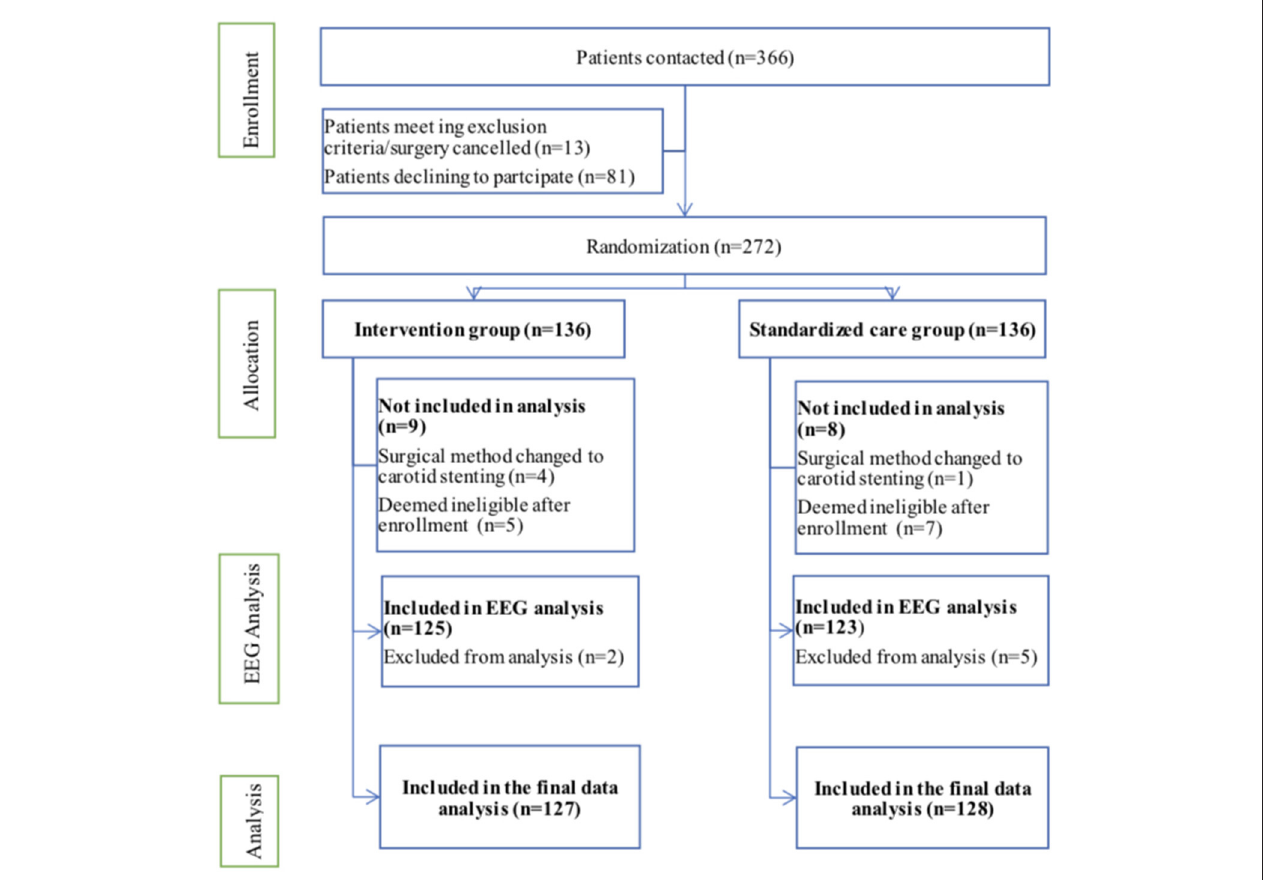
FIGURE 1 | Flow diagram depicting patient recruitment for this clinical trial. EEG,